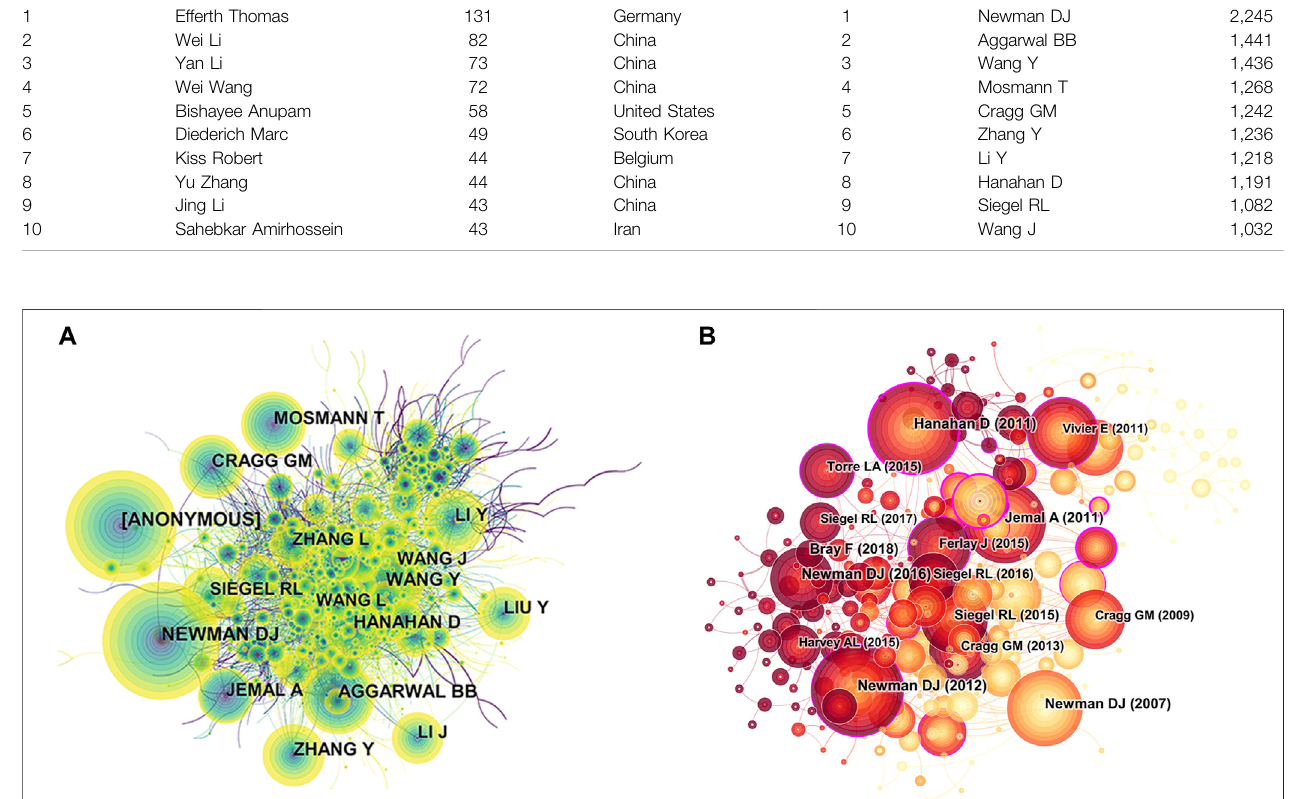
FIGURE 3 | CiteSpace network visualization map of co-cited authors and co-cited references related to natural products in cancer research. (A) The network visualizationmap ofco-citedauthors ofthepublication. (B) Thenetworkvisualizationmapofcited references.Thenodesrepresentco-citedauthors orcited references. The lines between the nodes represent co-citation relationships. The larger the node area, the larger the number of co-citations.